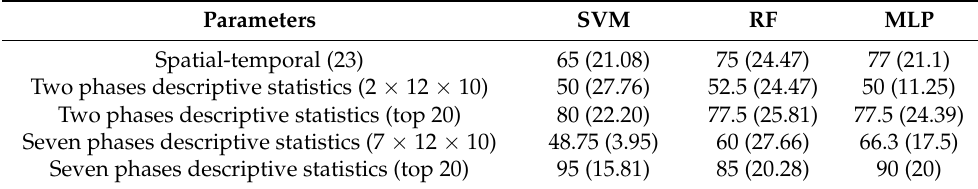
Table 5. Evaluation result of support vector machines (SVM), random forest (RF), and multilayer perceptron (MLP) (accuracy (standard deviation), %).